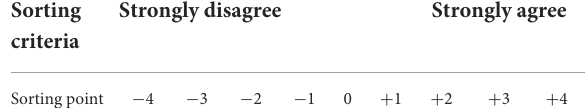
TABLE 1 Features of the sorting